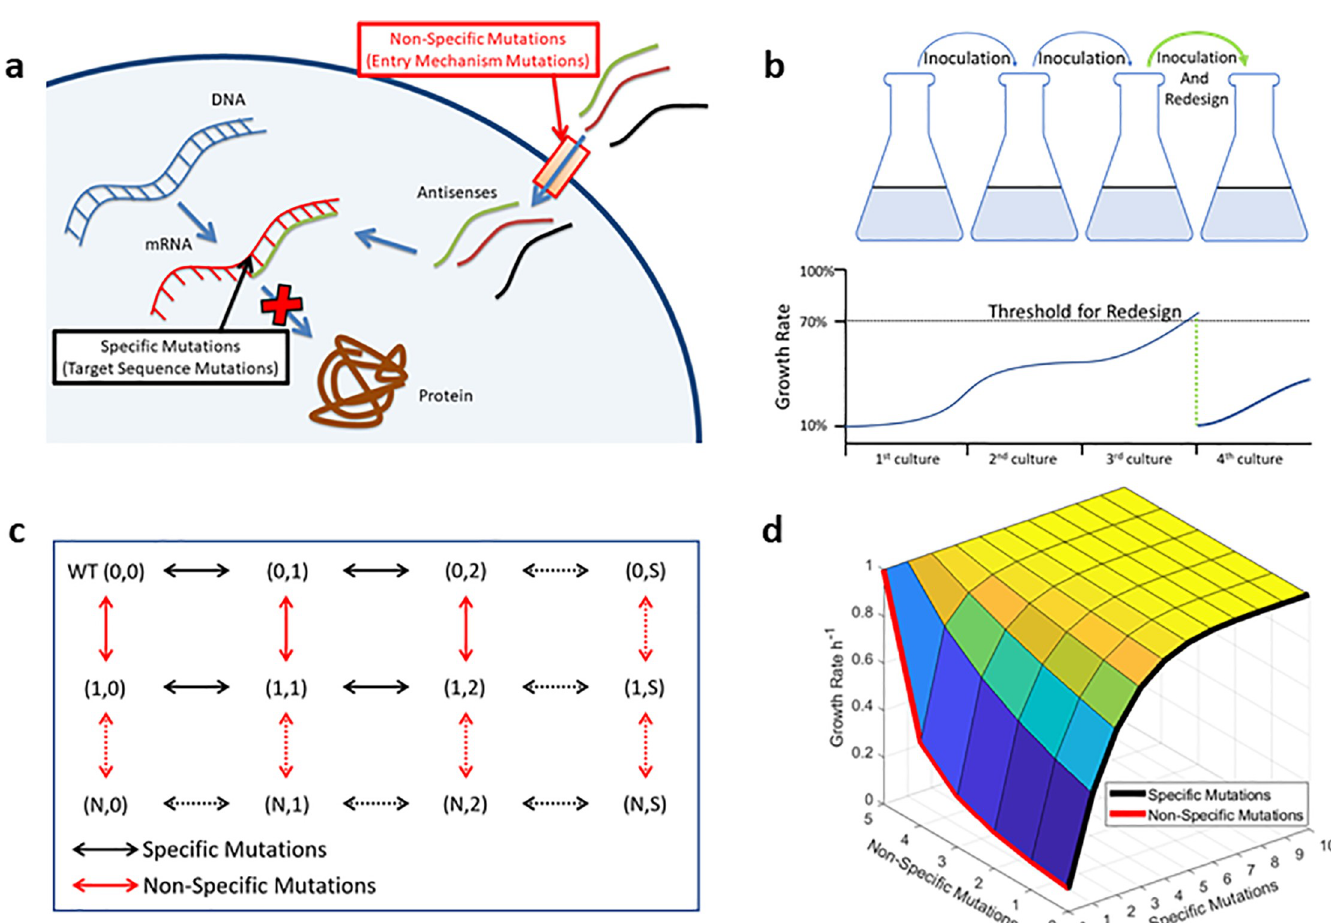
Fig 1. Kinetic Diagram of Subspecies mutations : a . Mechanism of action for antisense molecule. To alleviate its effects, there are two kinds of mutations: 1) specific mutations, nucleotide change in the target sequence, these mutations would only affect a “specific” antisense sequence. 2) nonspecific mutation, disruption in the entry mechanisms of antisense molecules, these mutations would nullify any antisense in “nonspecific” manner. b . Simulated system is bacteria grown in liquid culture. Computational experiments started with inoculated bacteria to a fresh medium containing antisense molecules. Growth continued until early stationary phase. Grown culture is used to transition to another medium. Serially passaged bacteria ensure continued evolution. After sufficient time, bacteria gain resistance to the therapy (growth rate surpassed a set threshold), at that time antisense therapy is redesigned. This action may or may not restore therapy effectiveness. If not, then therapy finalized. c . The kinetic diagram represents the mutational pathways. First, mutations in the targeted sequence (specific mutations, horizontal direction). Second, mutations that prevent entry of antisense into the bacterial cell (nonspecific mutations vertical direction). The direction of horizontal change is from left to right for acquiring specific resistance mutations. The direction of vertical change is from top to bottom for loss of delivery mechanisms. d . shows an example of a constructed fitness landscape. The height of the surface represents the growth rates associated with a kinetic diagram. The black edge represents the growth rates for specific mutations with all entry mechanisms kept intact. The red edge represents the growth rates associated with failing of entry mechanisms with 0 specific mutants. These two edges are used to derive all other growth rates, see methods for details.